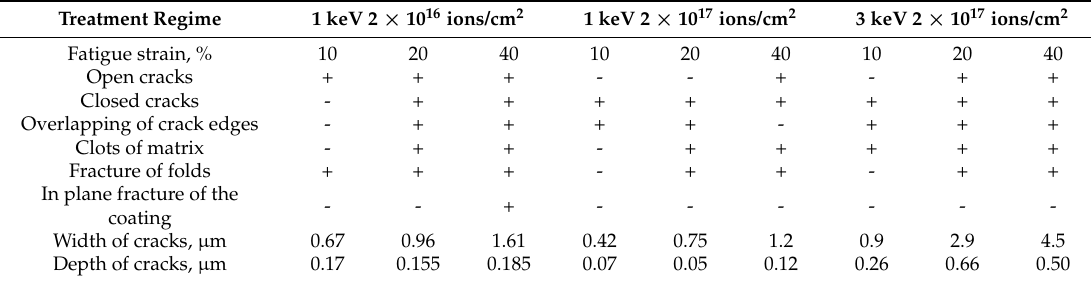
Table 1. Surface morphology after the fatigue